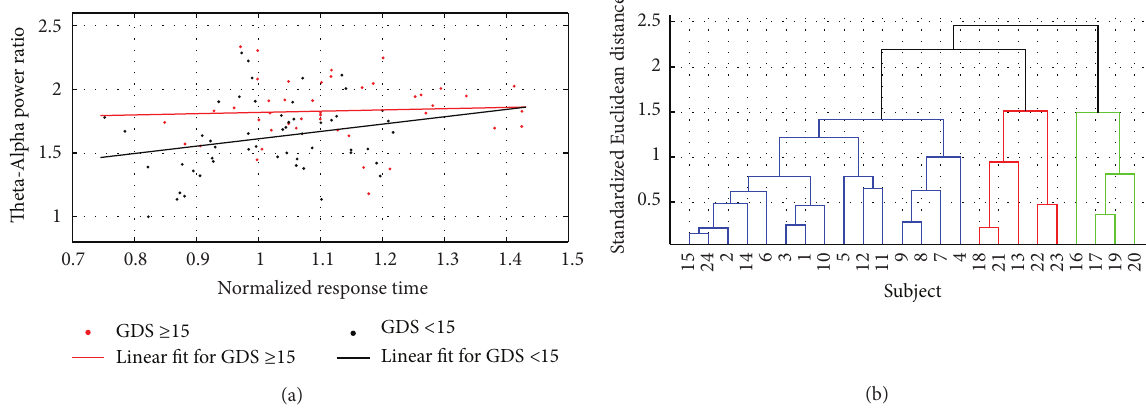
Figure 6: (a) Scatter plot between baseline-normalized cued response time and the Theta-Alpha power ratio, and linear regression fit for the “nondepressed” (GDS < 15) and “depressed” (GDS ≥ 15) QEEG groups. (b) Dendrogram plot of the hierarchical cluster tree from the data set—average slope of the Theta-Alpha power ratio versus average slope of baseline-normalized cued response time—providing three clusters shown with blue, red, and green colored